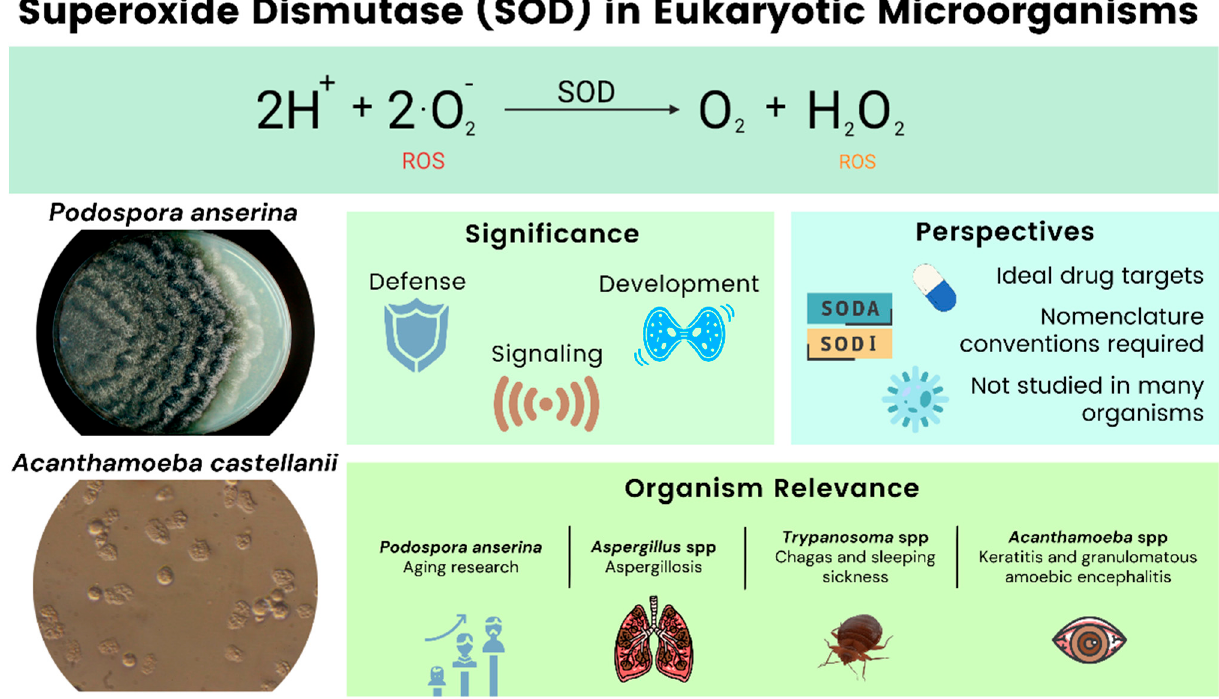
Figure 1. Overview of the article and the significance of SODs in eukaryotic microorganisms.